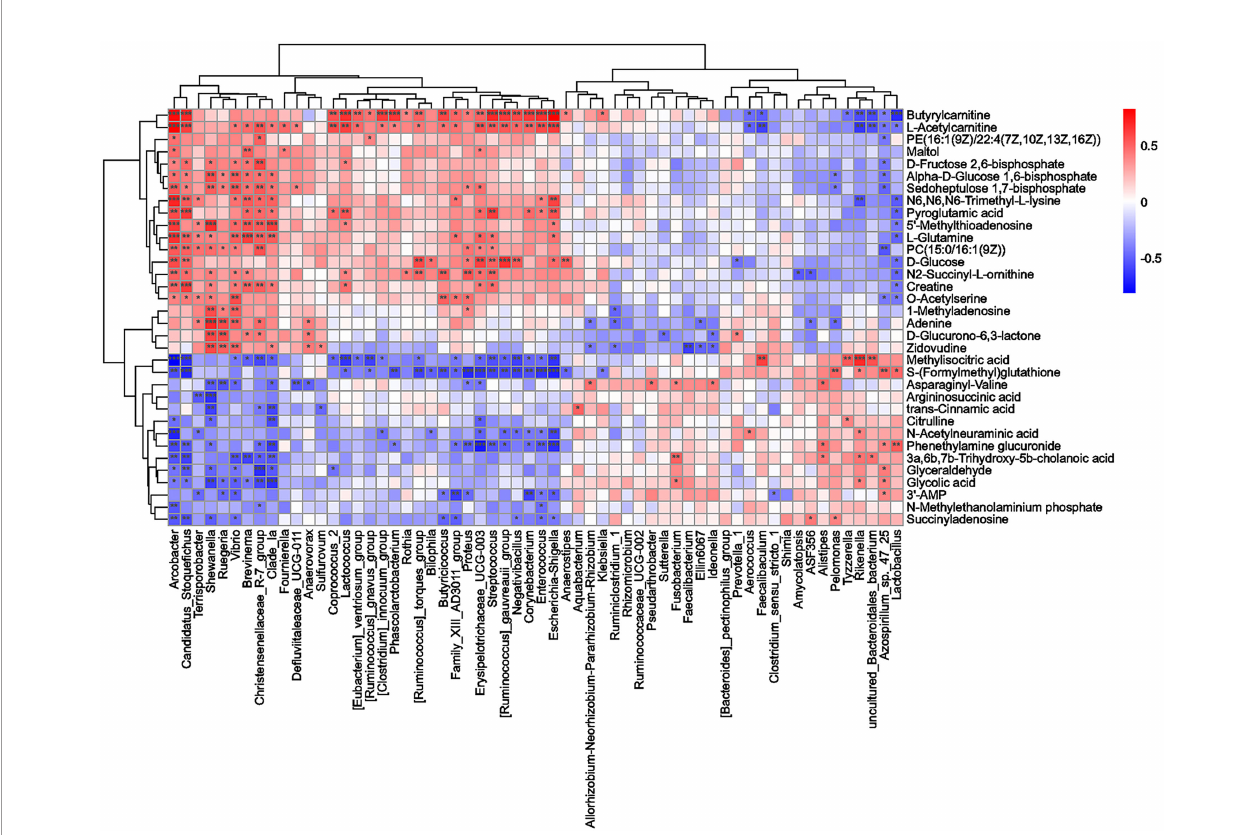
FIGURE 7 | Correlation analysis of differentially abundant microbial taxa and differentially abundant hippocampal metabolites. Spearman correlation coef fi cients were used to generate the matrix. The degree of correlation is shown by the gradient change in colors; red denotes a positive correlation, and blue denotes a negative correlation. *** p < 0.001, ** p < 0.01, * p <